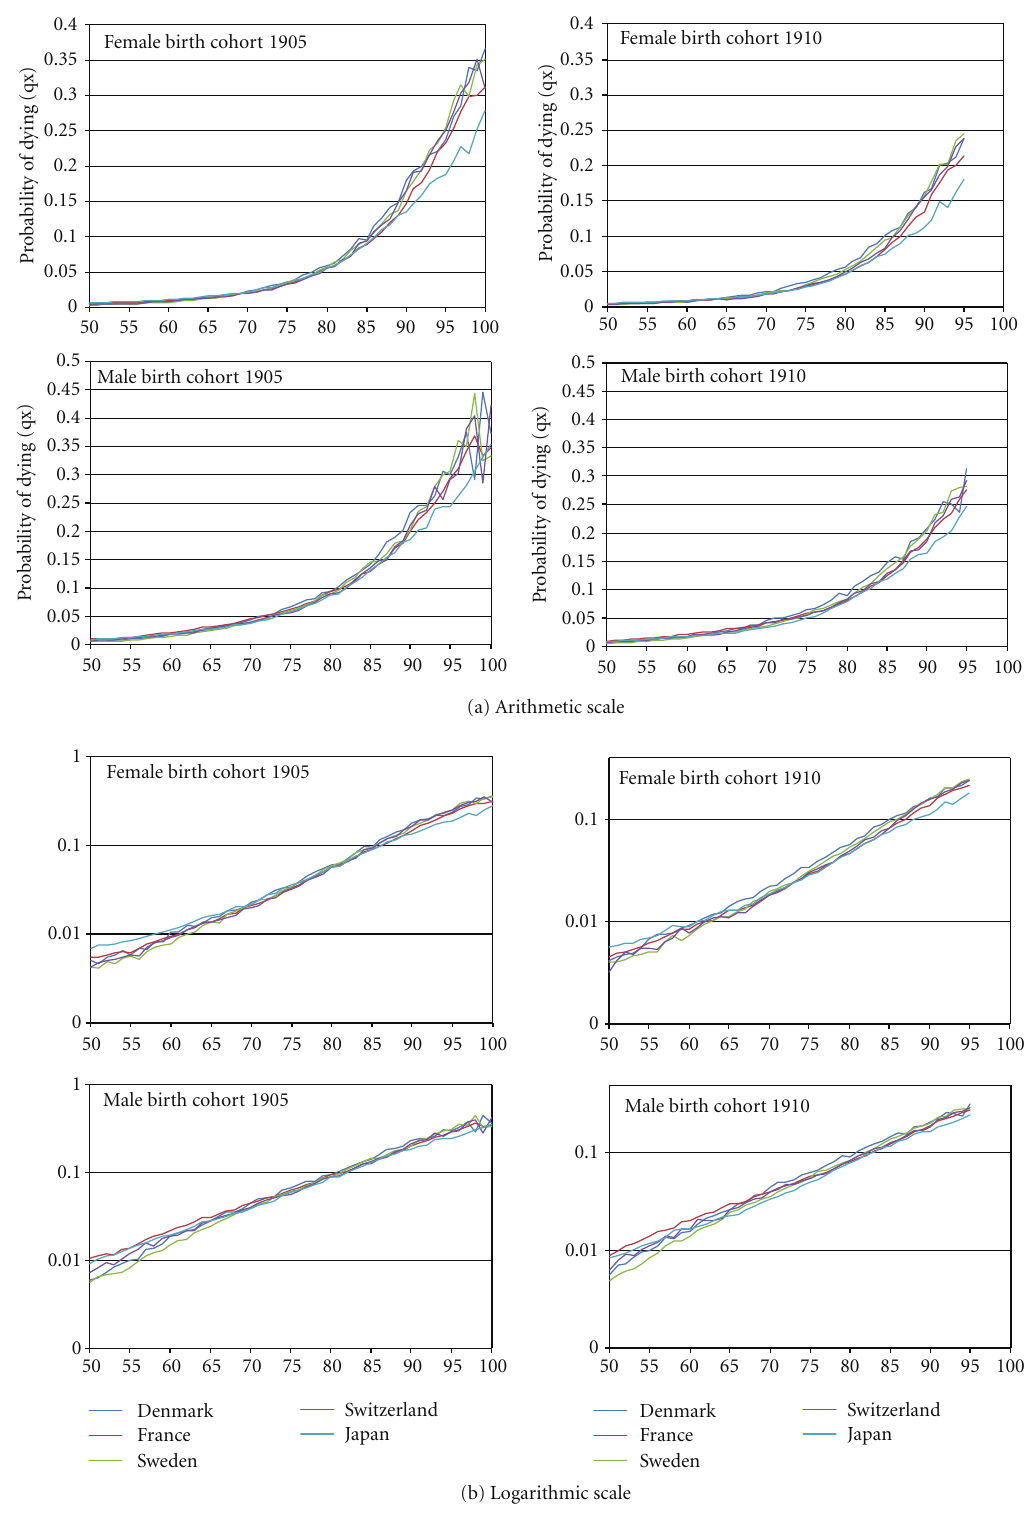
Figure 1: Mortality trajectory with age, from age 50, in the cohorts born in 1905 and 1910: Denmark, France, Japan, Sweden, and Switzer-